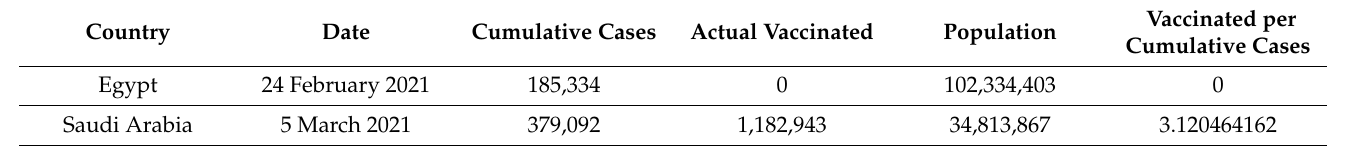
Table 3. Actual vaccinated people in first category countries